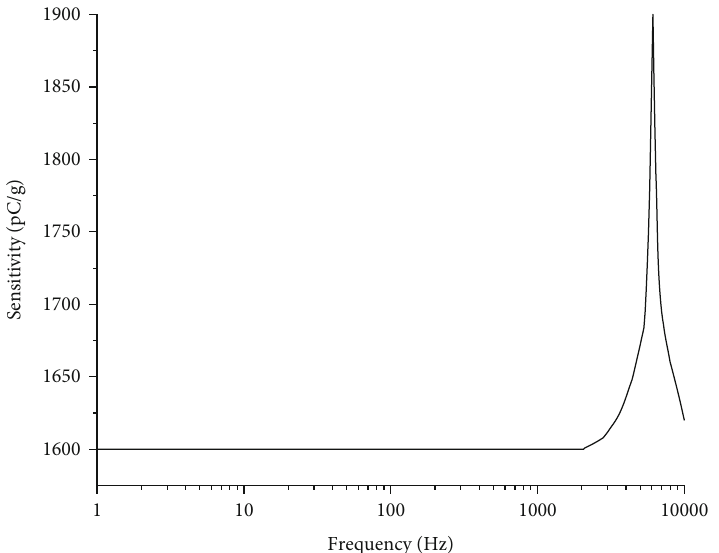
Figure 17: Charge sensitivity frequency response